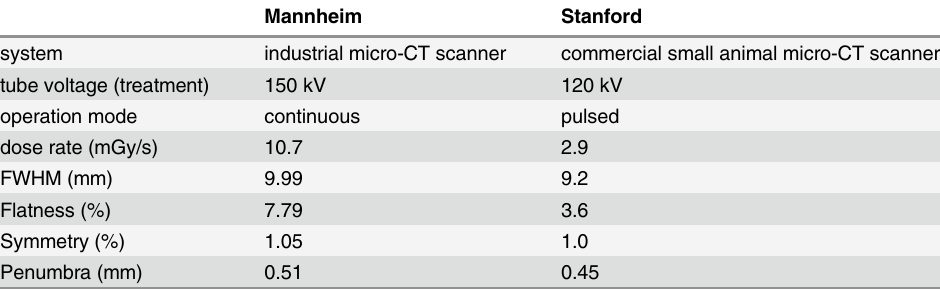
Table 2. Comparison between the systems of Mannheim and Stanford [1] for a field size of 1